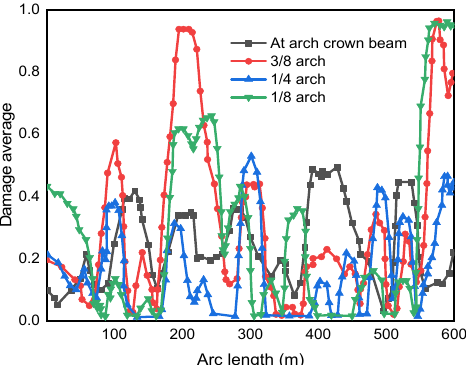
Figure 20. Dam crest damage curve for various horizontal blast positions. The maximum values of displacement, velocity, and acceleration in the full dynamic time history of each monitoring point at the dam crest are extracted to further investigate the dynamic response of the dam body under different initiation positions, as shown in Figure 21. As shown in Figure 21, as the initiation center moves from the arch crown can- tilever to the side arch end, the maximum value of displacement, velocity, and acceleration at the dam top also moves from the arch crown cantilever to the side dam end. When the detonation center is near the arch crown cantilever, i.e., near point A, the maximum value of displacement, velocity, and acceleration of each monitoring point on the dam crest is taken at point A. When the detonation center is at the 3/8 arch position, that is, close to the Z3 point, the maximum value of displacement, velocity, and acceleration of each monitoring point on the dam crest is taken at the Z3 point. When the detonation center is located at the 1/4 arch position, that is, near the Z2 point, the maximum value of displacement, velocity, and acceleration of each monitoring point on the dam crest is taken at the Z2 point. When the detonation center is located at the 1/8 arch position, that is, near the Z1 point, the maximum value of displacement, velocity, and acceleration of each mon- itoring point on the dam crest is taken at the Z1 point.